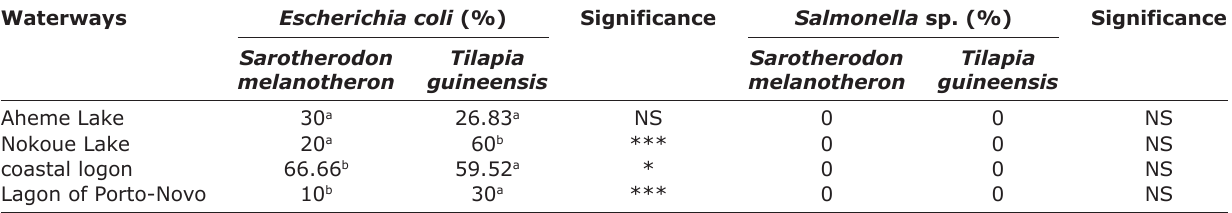
Table-4: Contamination level of salmonella and E. coli in Tilapia guineensis and Sarotherodon